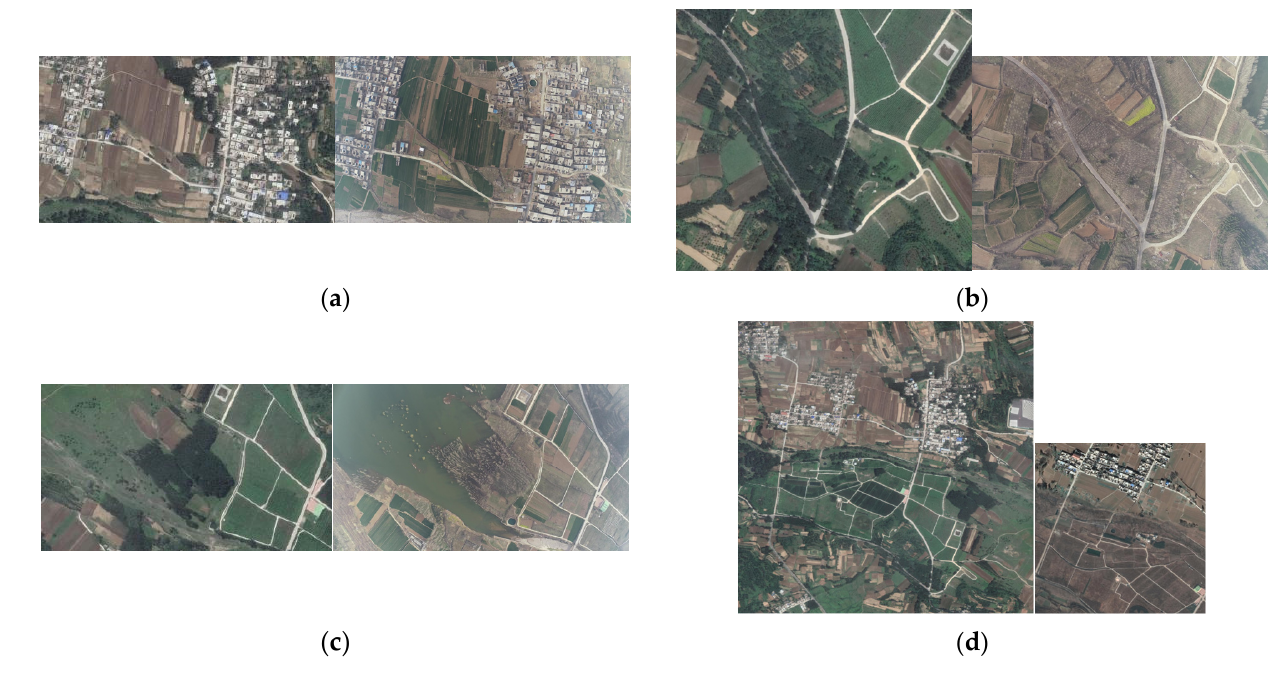
Figure 4. Experimental images: ( a ) image pair a, ( b ) image pair b, ( c ) image pair c, and ( d ) image pair